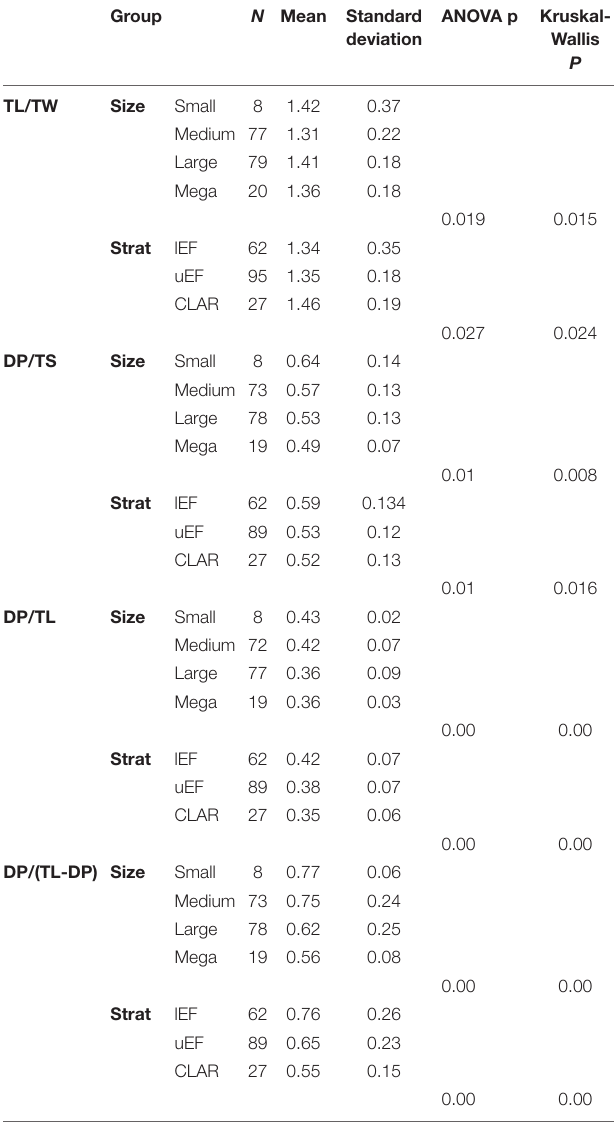
TABLE 1 | Summary statistics for equal distributions of bivariate ratio data for size and stratigraphic groupings, where p < 0.05 is statistically significant.